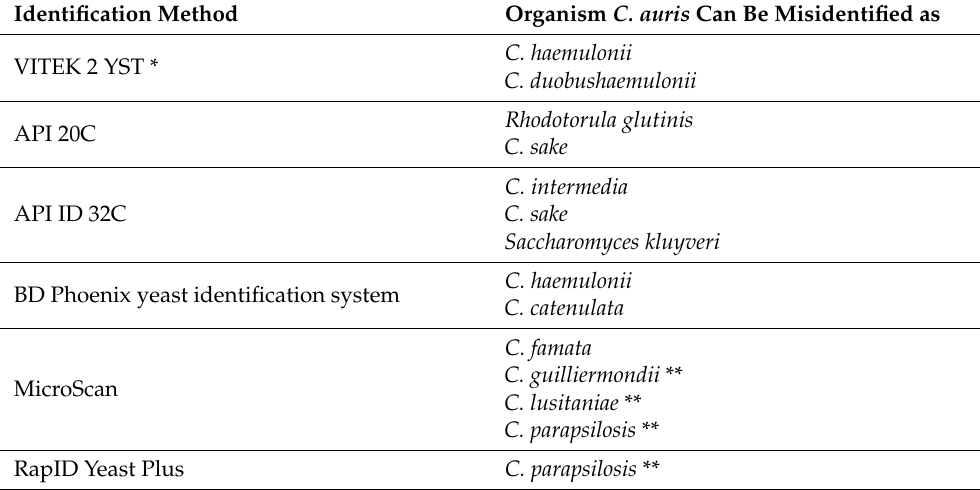
Table 2. Commercial identification methods that can misidentify C. auris